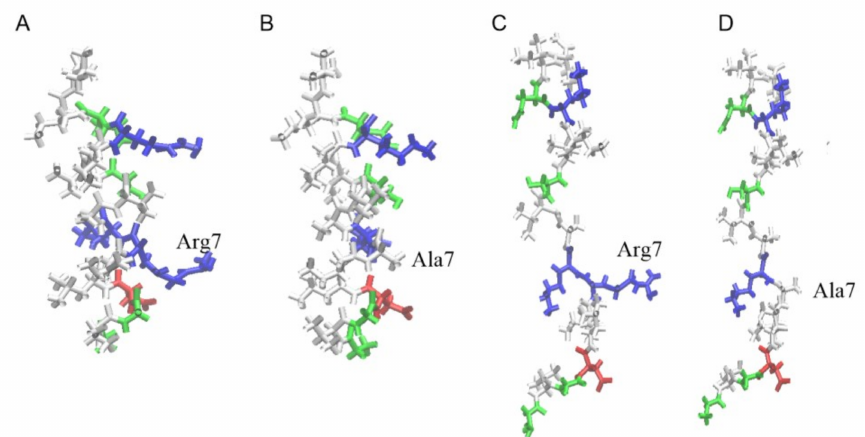
Figure 1. Structure of uperin and mutant in alpha-helical form ( A , B ) and in extended configuration ( C , D ). Peptides are shown in bonds and are colored according to residue